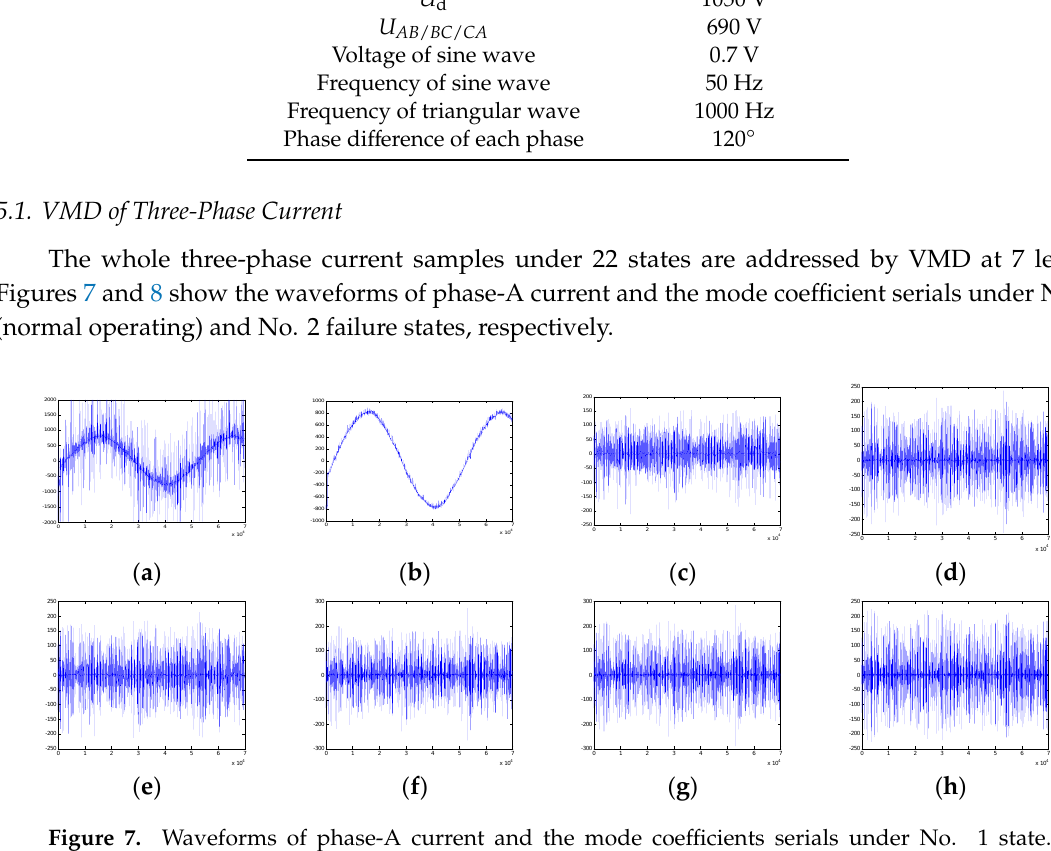
( h ) Figure 8. Waveforms of phase-A current and the mode coefficients serials under No. 2 failure state. ( a ) Waveform of phase-A current. ( b – h ) Waveforms of mode coefficients serials from 1st level to 7th level. 1.